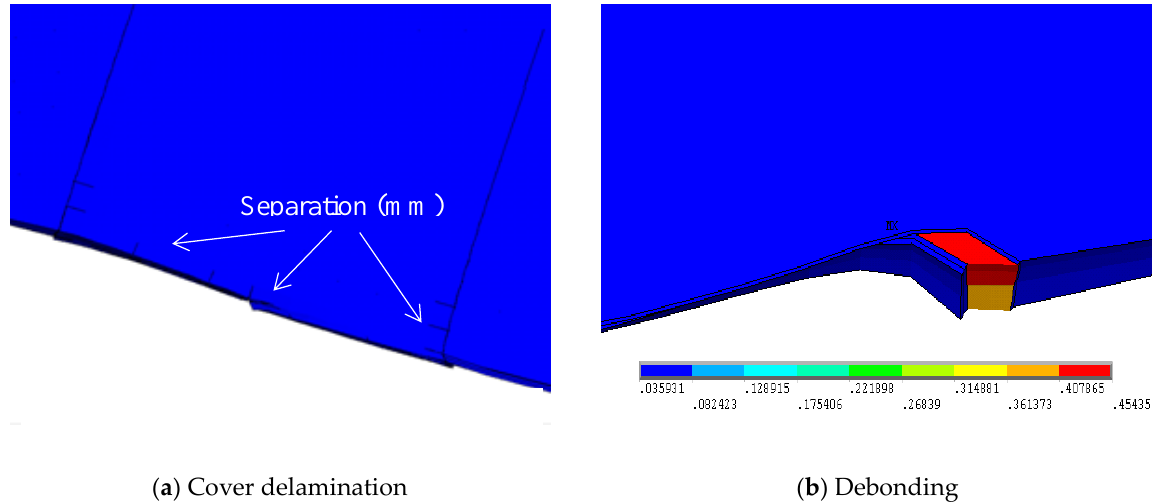
Figure 5. Comparison between the failure modes of the experimental and FE models developed in ANSYS: ( a ) Cover delamination; ( b ) Debonding.